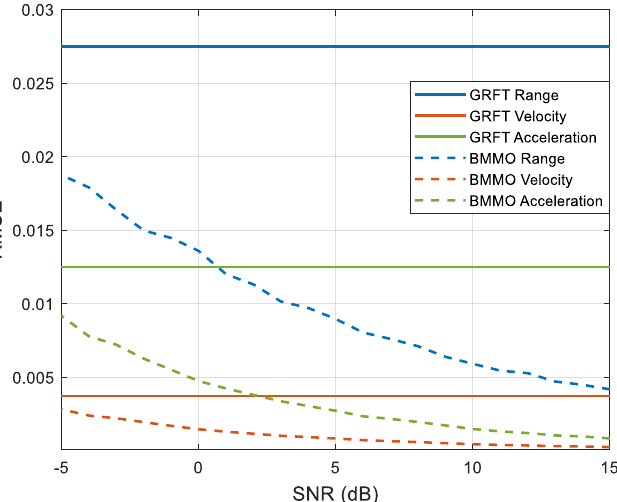
Figure 8. Motion parameter estimation root mean square error (RMSE) of GRFT-erg and BMMO in different motion orders.